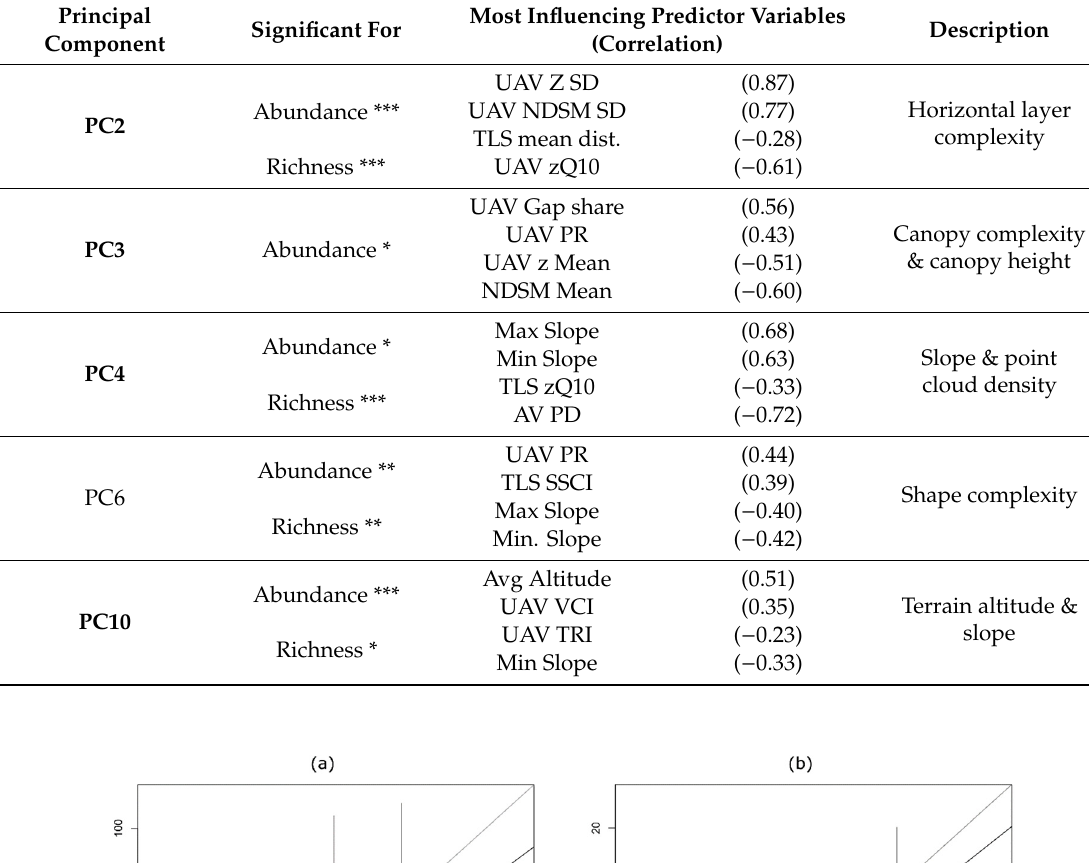
Table 2. Statistical significant principal components ( p -values: * < 0.05, ** < 0.01, *** < 0.001) according to the GAMs and their most important influencing variables based on the correlation between the PC and the predictor calculated by the dimdesc function from the factominer package [62].